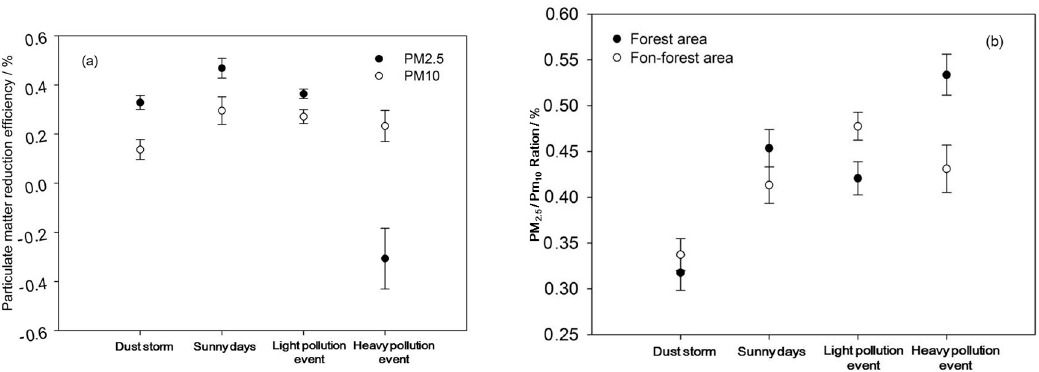
Figure 10. Reduction e ffi ciency for PM 2.5 and PM 10 ( a ) and PM 2.5 / PM 10 ratio ( b ) in forest area and non-forest